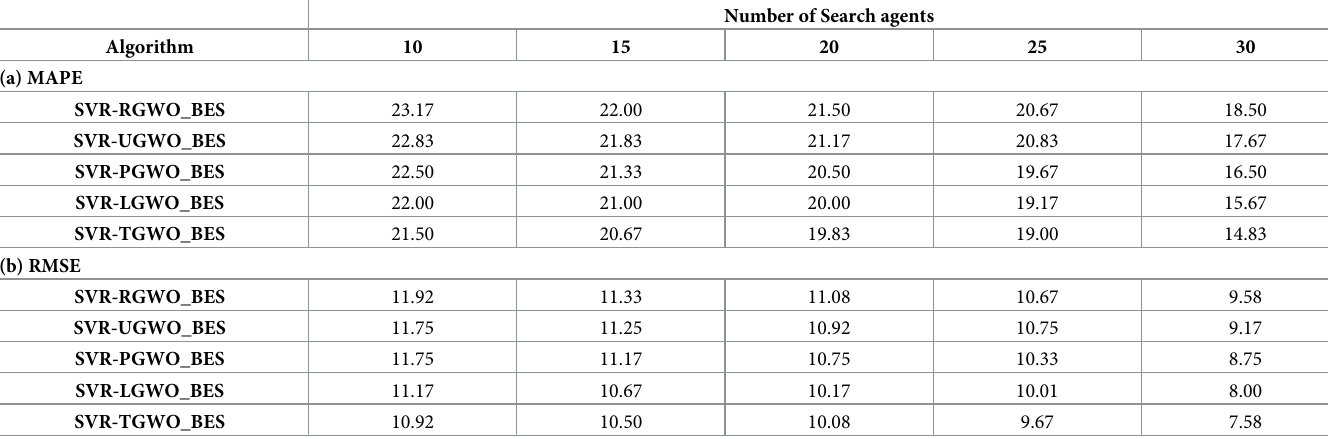
Table 3. Error measure for traffic prediction for increasing search agents–(a) MAPE and (b) RMSE.